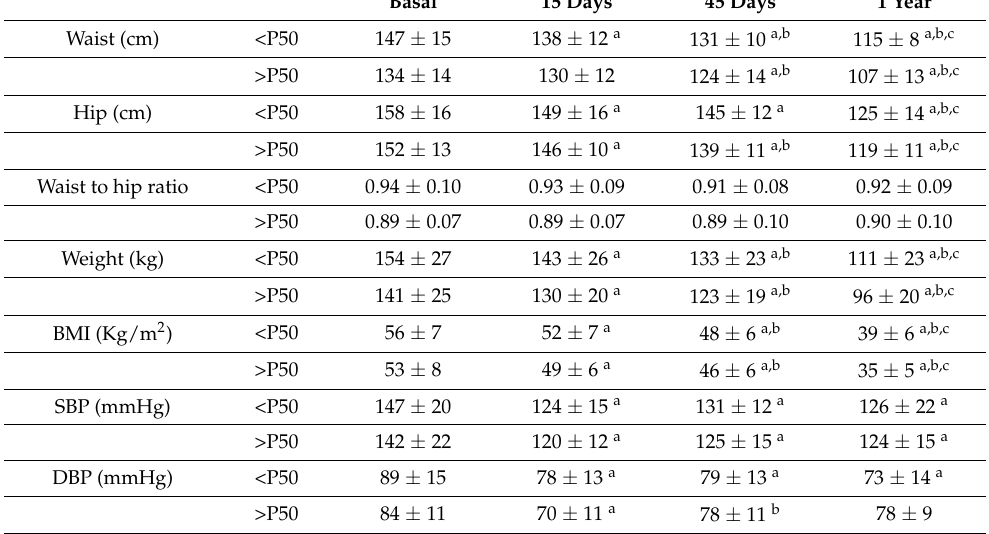
Table 3. Changes in clinical and biochemical variables in patients with class III obesity before bariatric surgery (Basal) and 15 days, 45 days, and 1 year after bariatric surgery according to visceral (VAT) ZAG gene expression levels. Patients are stratified by the 50th percentile of VAT ZAG gene